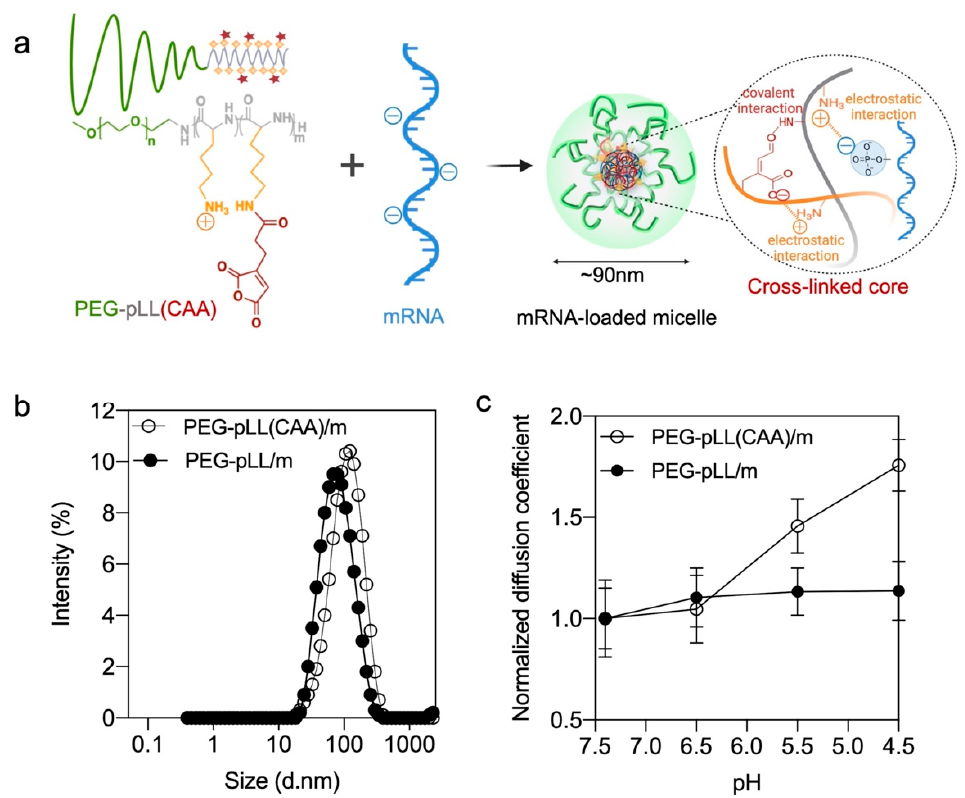
Figure 1. Micelle formation and characterization. ( a ) mRNA-loaded micelles formation based on electrostatic interaction and covalent interaction. ( b ) Size distribution of mRNA-loaded micelles by intensity (%) as determined by DLS. ( c ) Diffusion coefficient of micelles versus buffer pH (10 mM HEPES with 150 mM NaCl) having different pHs determined by FCS. The results are expressed as the mean ± s.d. ( n = 10).